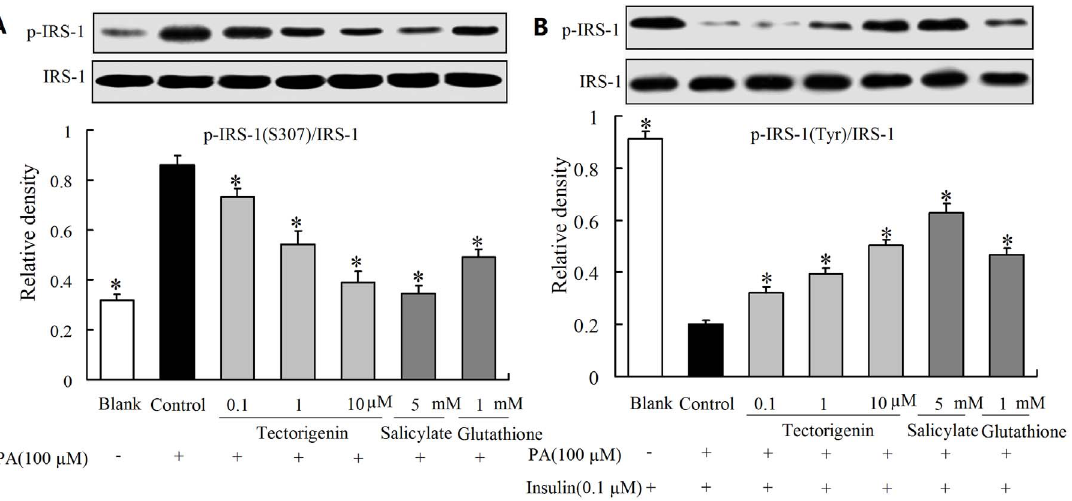
Figure 5. Tectorigenin modulated IRS-1 serine/tyrosine phosphorylation in PA-treated HUVECs. Cells were incubated with tectorigenin, salicylate or GSH for 30 min, and then stimulated without or with PA (100 m M) for 30 min. (A): Serine (S307) phosphorylation of IRS-1 was assayed by Western blot; (B): After stimulated with PA, HUVECs were then treated with insulin (100 nM) for 20 min. Tyrosine phosphorylation of IRS-1(detected by PY99 antibody) was then determined by Western blot. Salicylate and GSH were taken as positive controls. The blank was treated with an equal amount of the vehicle (medium containing 0.1% DMSO and 10% BSA). The results were expressed as mean 6 SD of three independent experiments. * p , 0.05 vs control